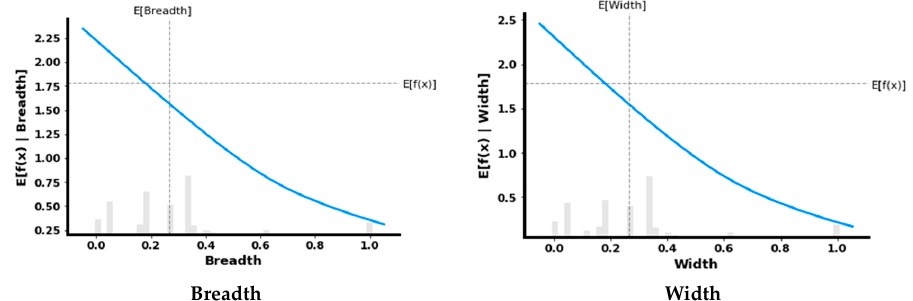
Figure 14. Partial dependence plots to interpret the predictions of the DL model. An additive force layout plot can be generated to visualize prediction by means of SHAP values (see Figure 15). It demonstrates which factors contributed how much favor- ably or adversely to the basic value in order to make a prediction. Figure 15a is clustered force plot or clustering shap values to visualize the force layout of all the test data. The clustered force plot is shown only for 18 test data for the clear demonstration. Figure 15b– e demonstrates individual force plots for 6 test points. The pink arrows reflect SHAP val- ues that increase the prediction value (to the right), while the green arrows show those that decrease the prediction value (to the left). Each arrow’s size shows the magnitude of the influence of the related characteristic. The “base value” is the model’s average predic-